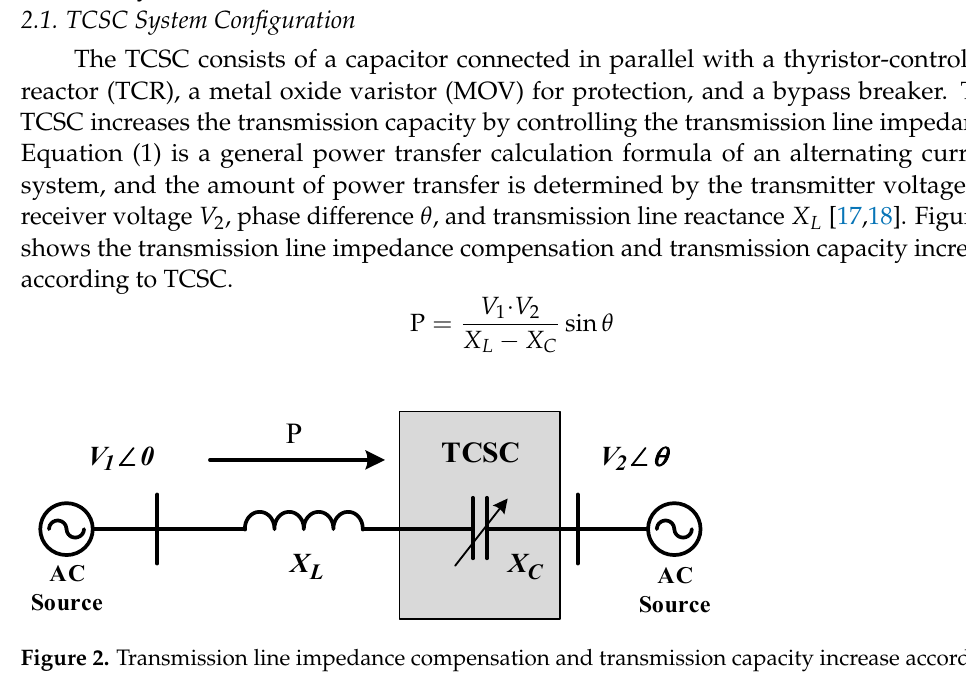
Figure 2. Transmission line impedance compensation and transmission capacity increase according to